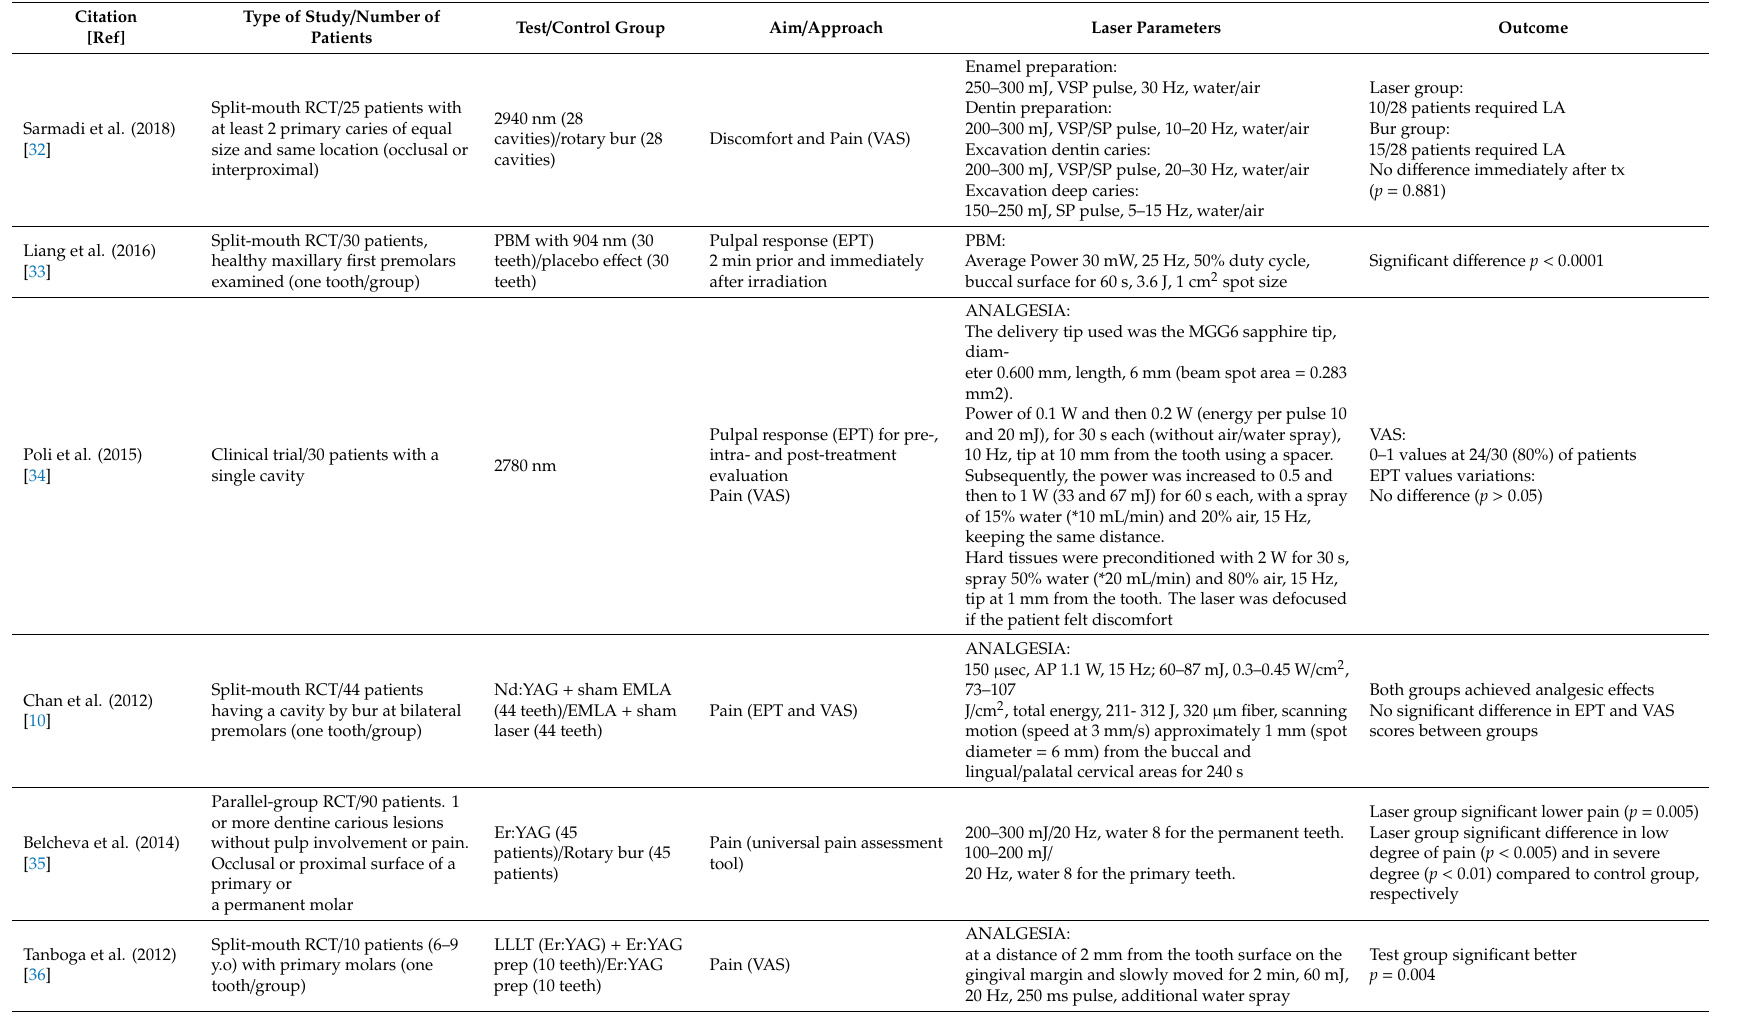
Table 1. Data evaluation of the included